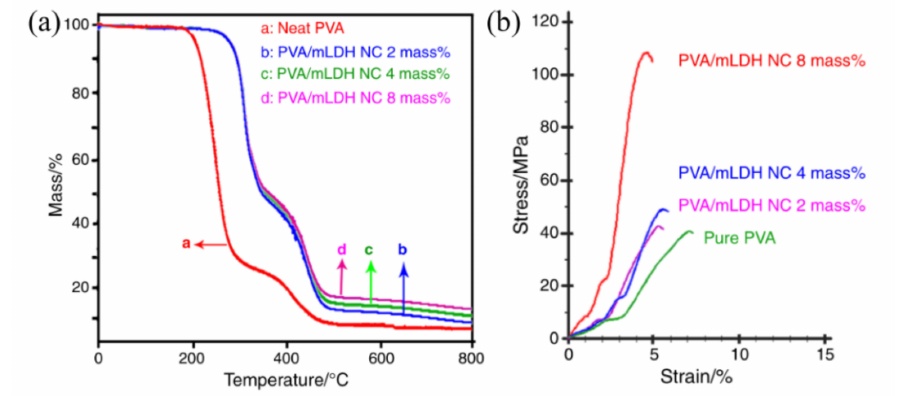
Figure 9. The pure PVA and PVA/mLDH NCs images of ( a ) TG curve; ( b ) typical stress–strain diagrams. Reprinted with permission from [68]; Copyright 2017